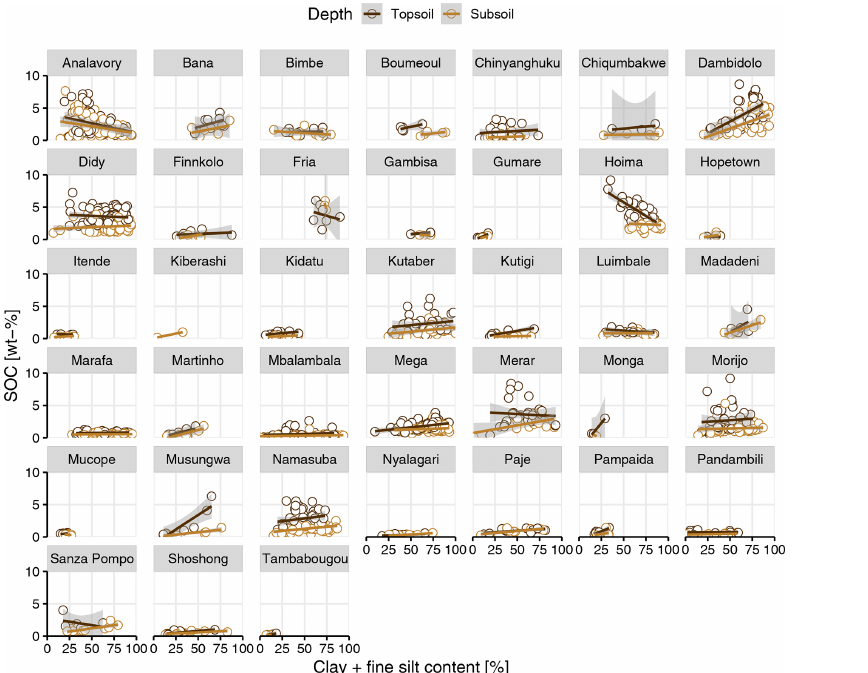
Figure A5. Soil organic carbon (SOC; wt%) and clay + fine silt content (percent) by depth for each sampling site that contained more than one sample per depth layer (0–20cm – topsoil; 20–50cm – subsoil). The gray area around fitted linear regressions represents the 95% confidence interval.